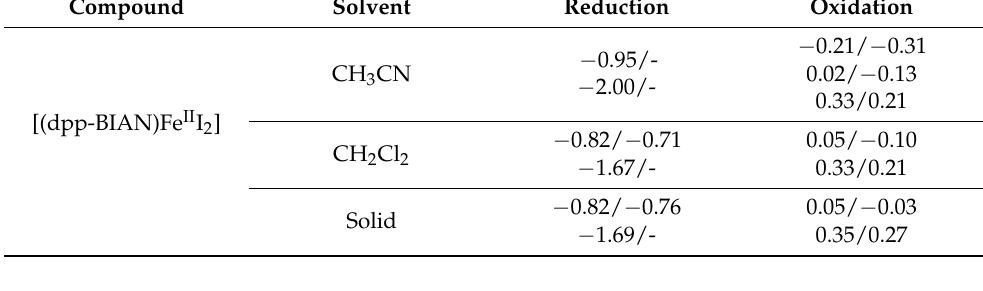
Figure 5. Cyclic voltammograms (CVs) of [(dpp-BIAN)Fe II I 2 ]. Black lines: WE: CPE (graphite + ionic liquid + [(dpp-BIAN)Fe II I 2 ]); blue lines: WE: GC; CH 2 Cl 2 ; and red lines: WE: GC; CH 3 CN, 10 -1 M Table 3. Peak potentials (V) for 1 (potentials vs. Fc/Fc + ).